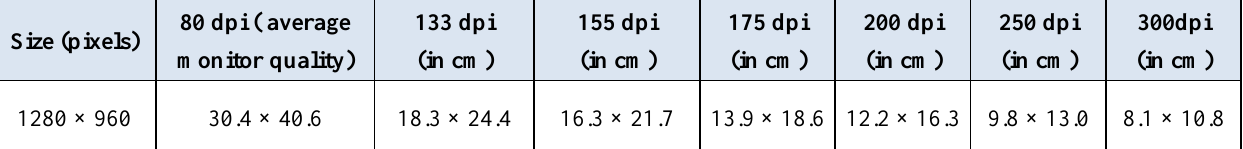
Table 5. Image size